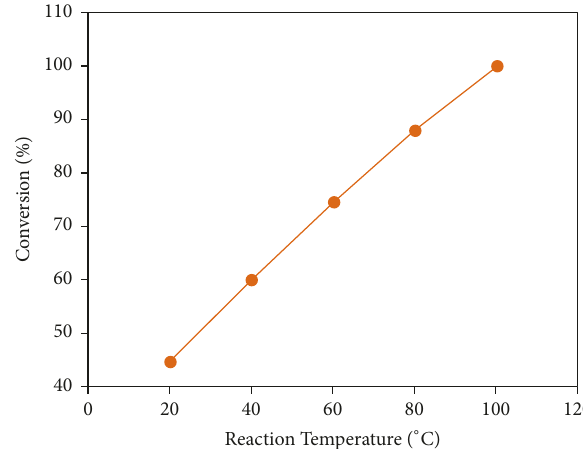
Figure 8: Catalytic performance of 1% ZrO function of reaction